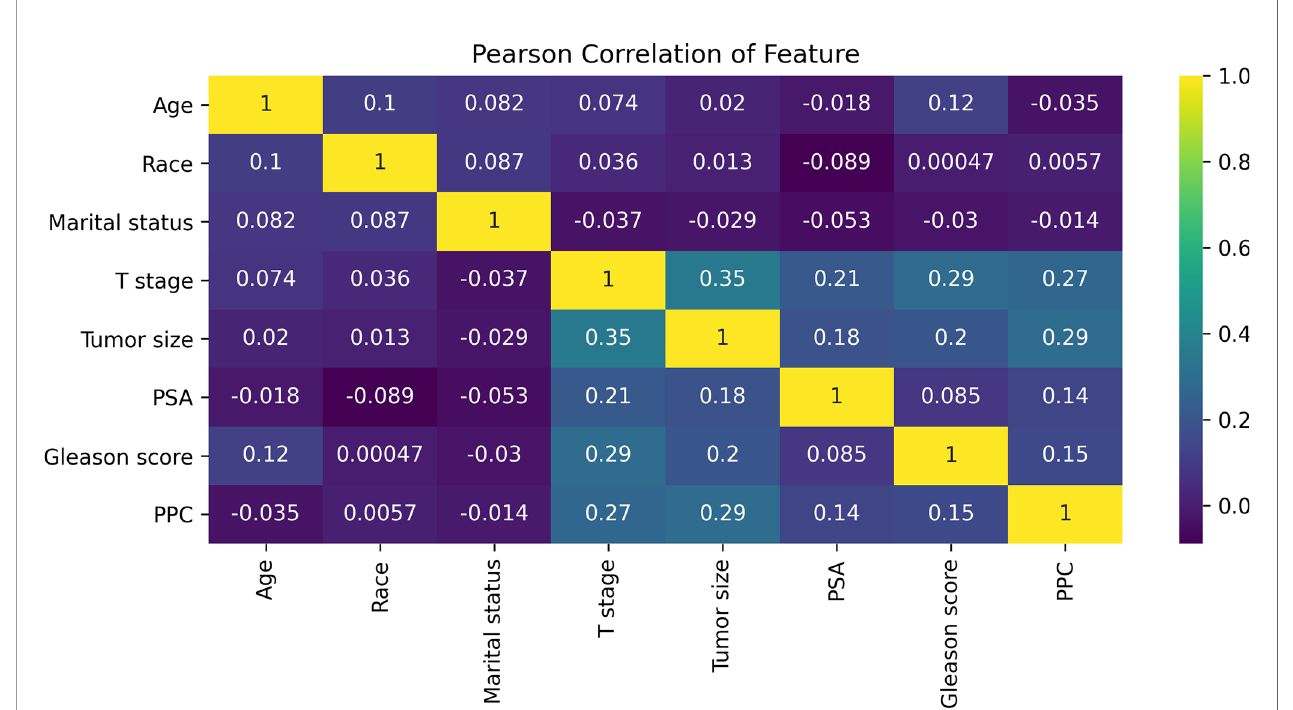
FIGURE 2 | The results of Pearson correlation analysis between all the variables. The heat map shows the correlation between the variables. Abbreviations: PSA, prostate-speci fi c antigen; PPC, percentage of positive